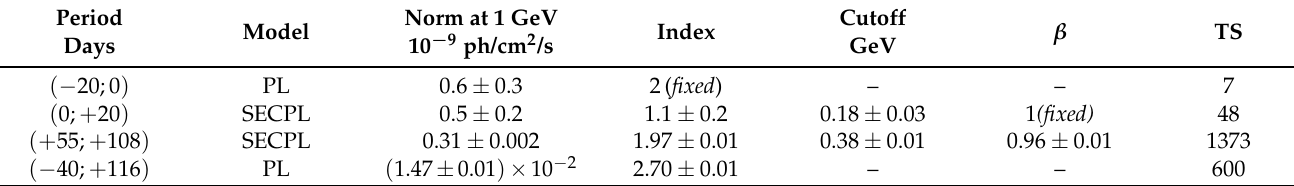
Table 1. The best-fit parameters of the models (PL–power law or SECPL–super-exponential cutoff power law with exponent index β ) used to fit Fermi/LAT data during different periods of the 2021 periastron passage in 0.08–2 GeV energy band. See text and Figure 3 for the